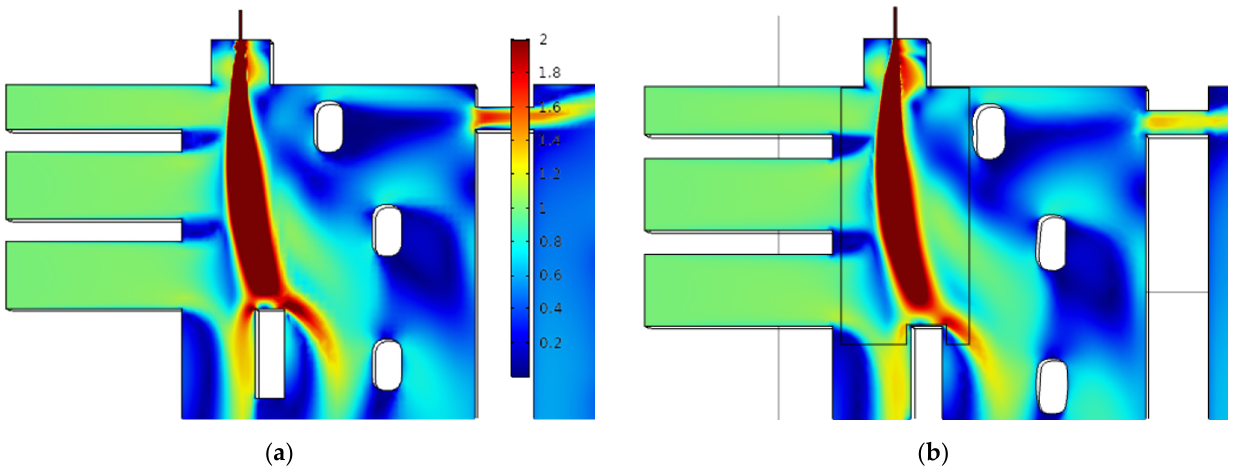
Figure 13. Comparison between velocity field results (m/s) at the combustion zone using ( a ) mesh 2 used in model 9 and ( b ) mesh 3 used in model 8.